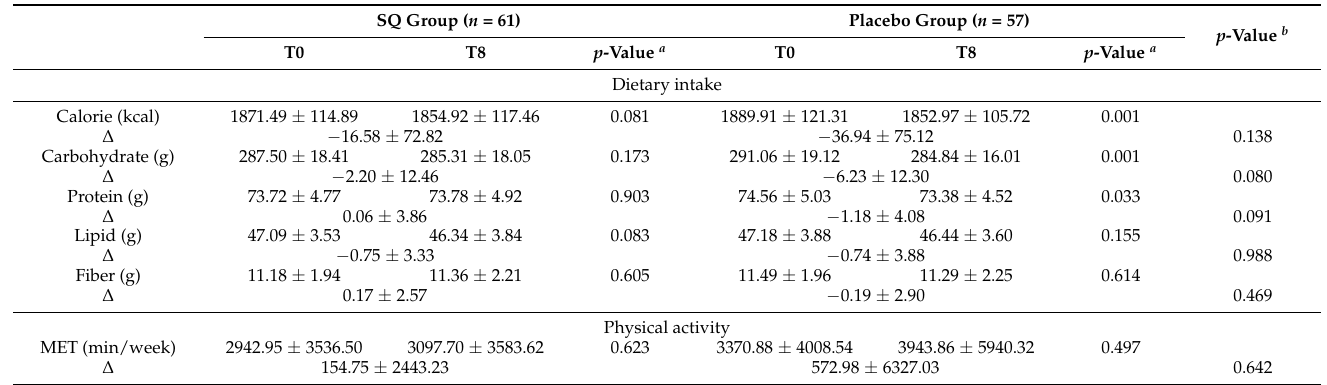
Table 3. Dietary intake and physical activity changes.